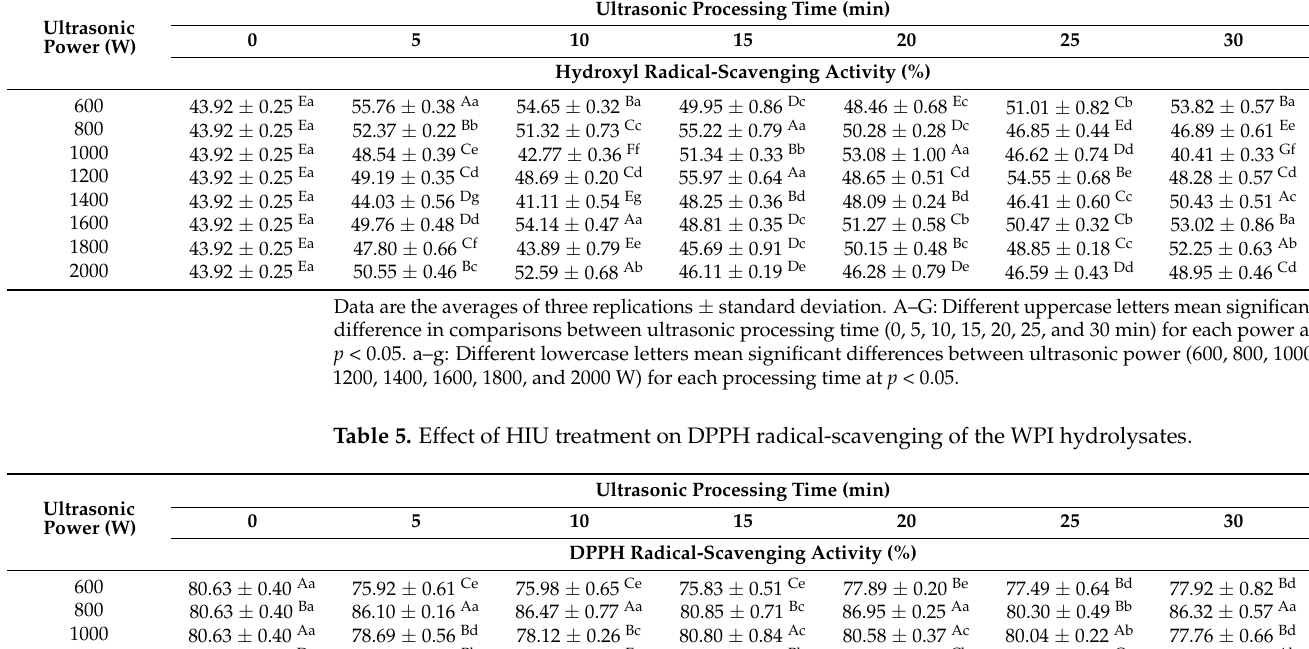
Table 4. Effect of HIU treatment on hydroxyl radical-scavenging of the WPI hydrolysates. Ultrasonic Processing Time (min) Ultrasonic Power (W)